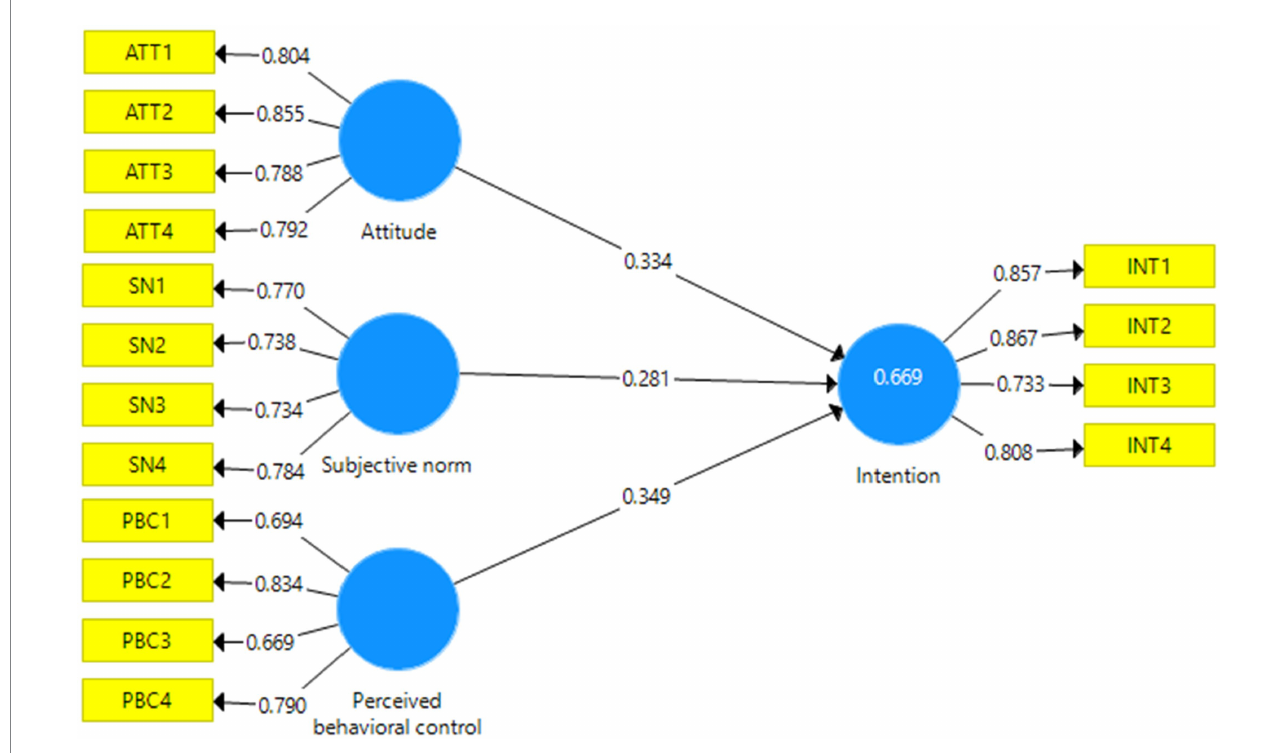
FIGURE 4 Original TPB structural model with standardized path